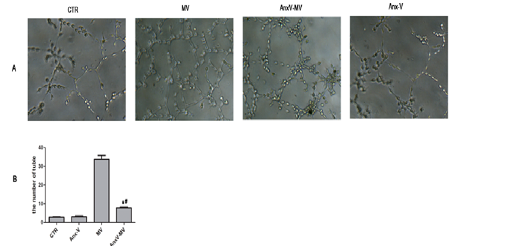
Fig 6. Blockage to PS on the MVs abrogates their ability to promote tube formation of HUVECs. (A) The vessel structure formation of HUVECs. CTR: Control, without MSC-MVs; MV: HUVEC+MSC-MVs; Anx- V-MV: HUVEC+Anx-V-MVs; (B) The mean number of 5 sites vessel structure ( * P: vs .CTR < 0.001; # P: vs .MVs < 0.001; n = 3).